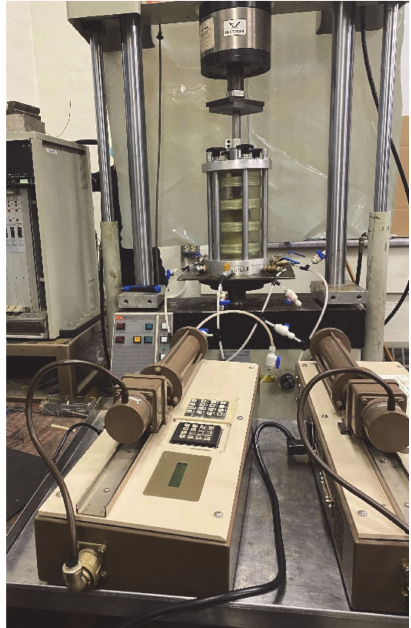
Figure 3. The Triaxial testing